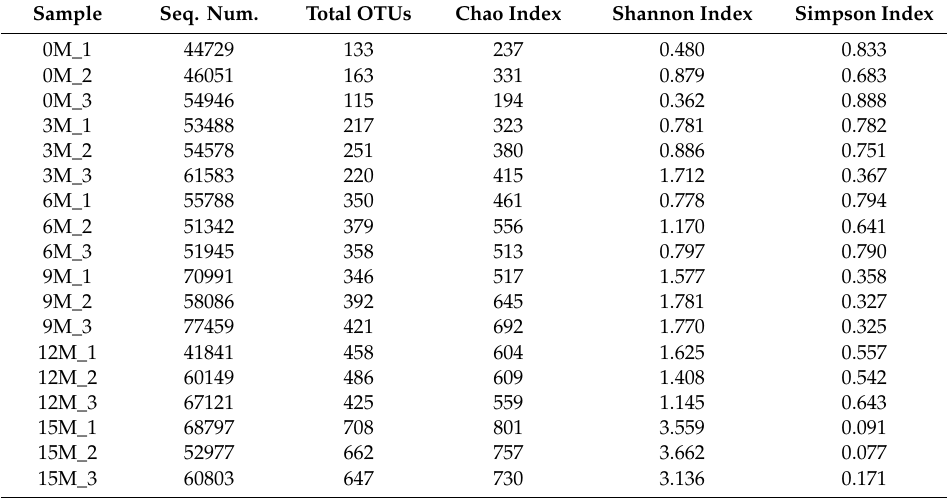
Table 2. 16S rRNA sequencing and diversity data statistics of bacteria in fish sauce during